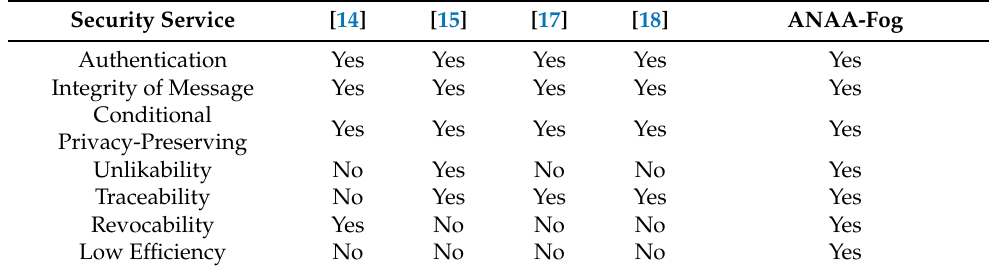
Table 3. Comparison of security